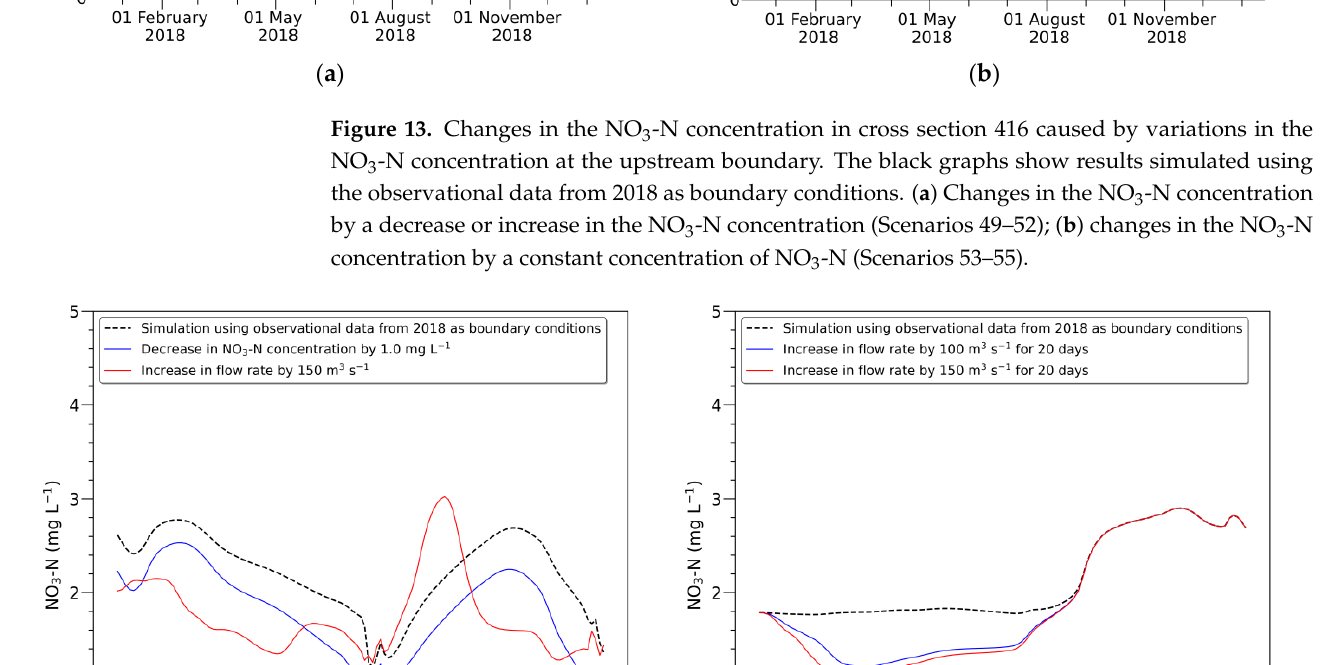
Figure 14. Changes in the NO 3 -N concentration in cross section 416 caused by a decrease in the NO 3 -N concentration at the upstream boundary or an increase in flow rate at the upstream boundary. The black graphs show the result simulated using the observational data from 2018 as boundary conditions. ( a ) Changes in the NO 3 -N concentration by a decrease in the NO 3 -N concentration (blue graph) or an increase in flow rate (red graph); ( b ) changes in the NO 3 -N concentration by an increase in flow rate of 100 m 3 s − 1 (blue graph) and 150 m 3 s − 1 (red graph) for 20